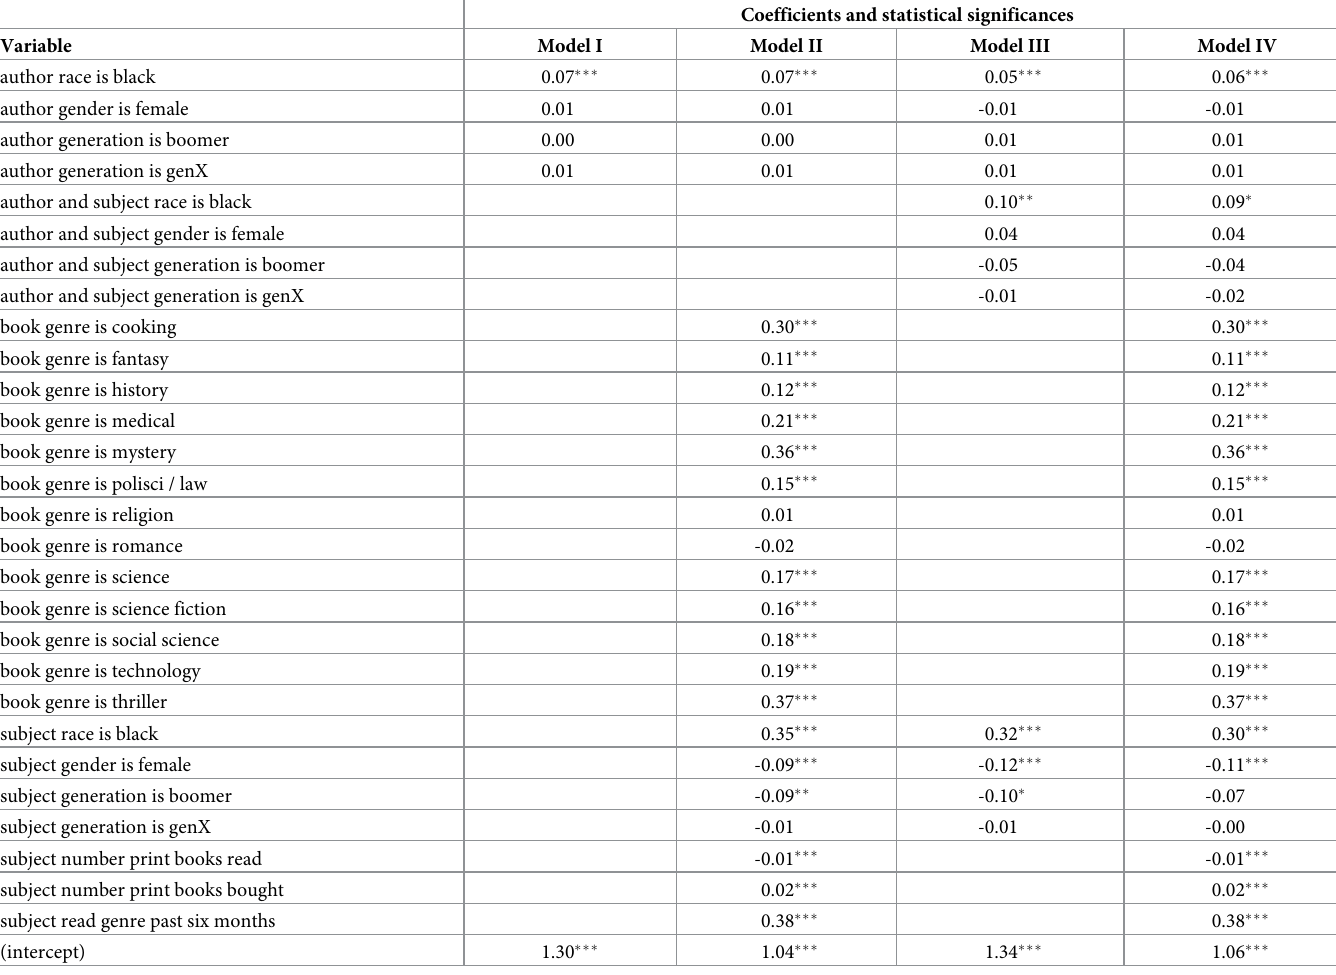
Table 7. Purchase interest in the surveyed